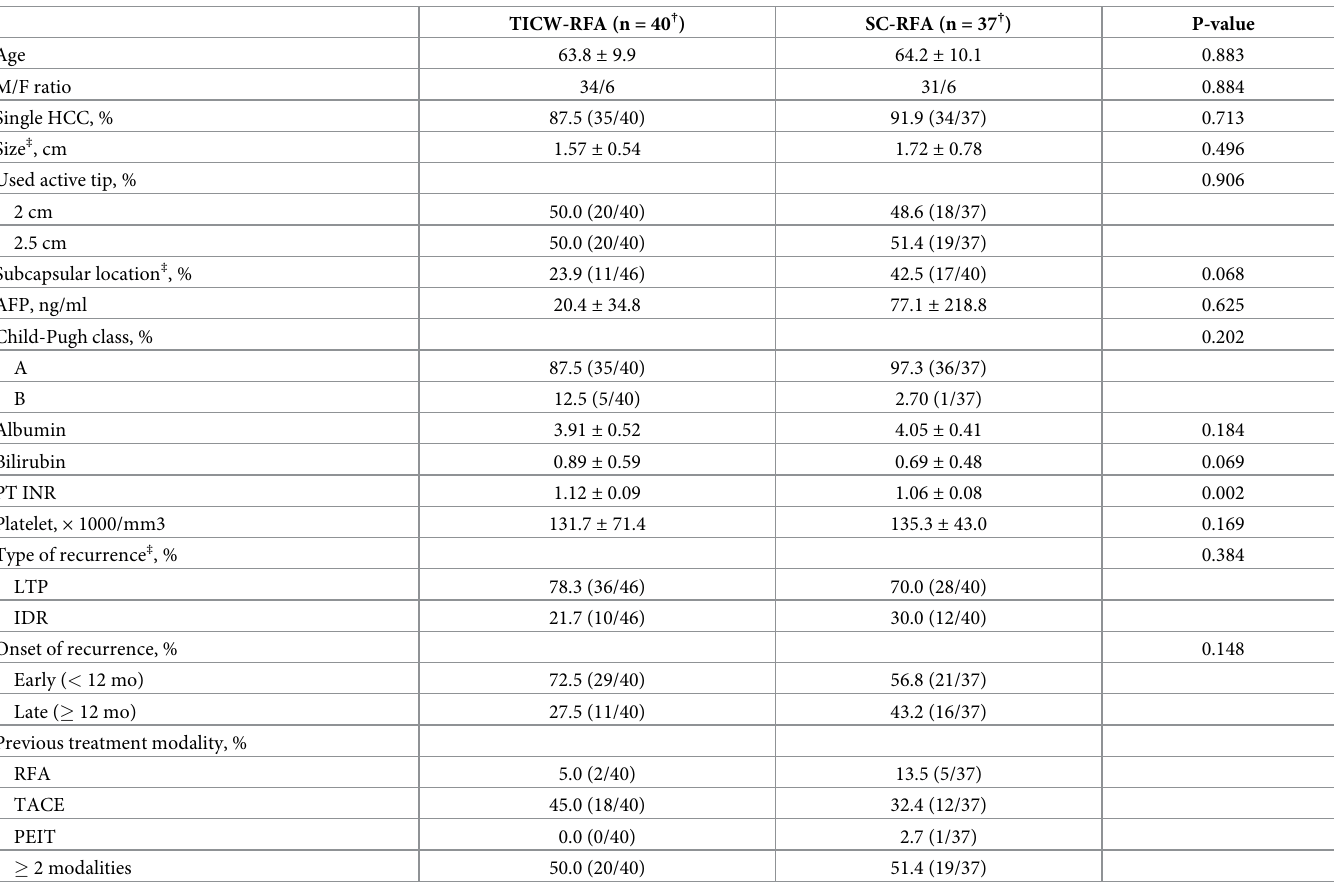
Table 1. Baseline characteristics of the study